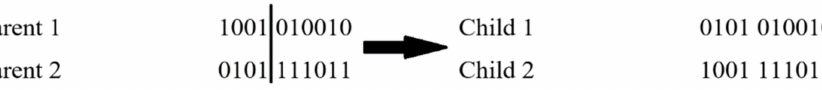
Figure 7. Crossover operator